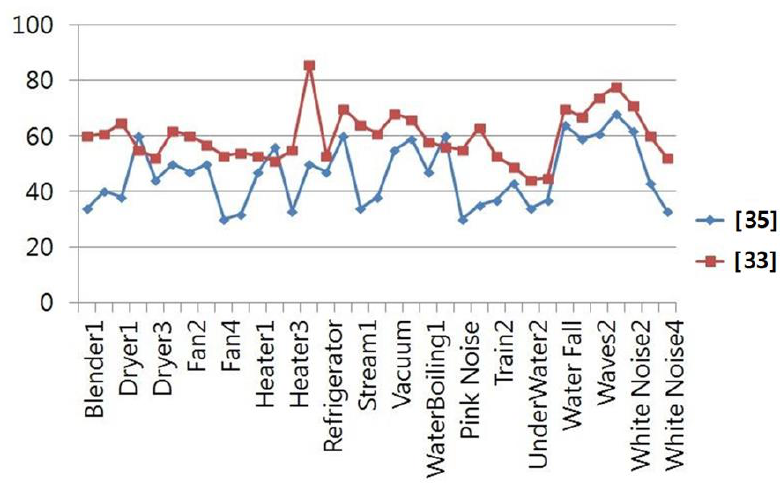
Figure 11. Measurements from references [33,35].